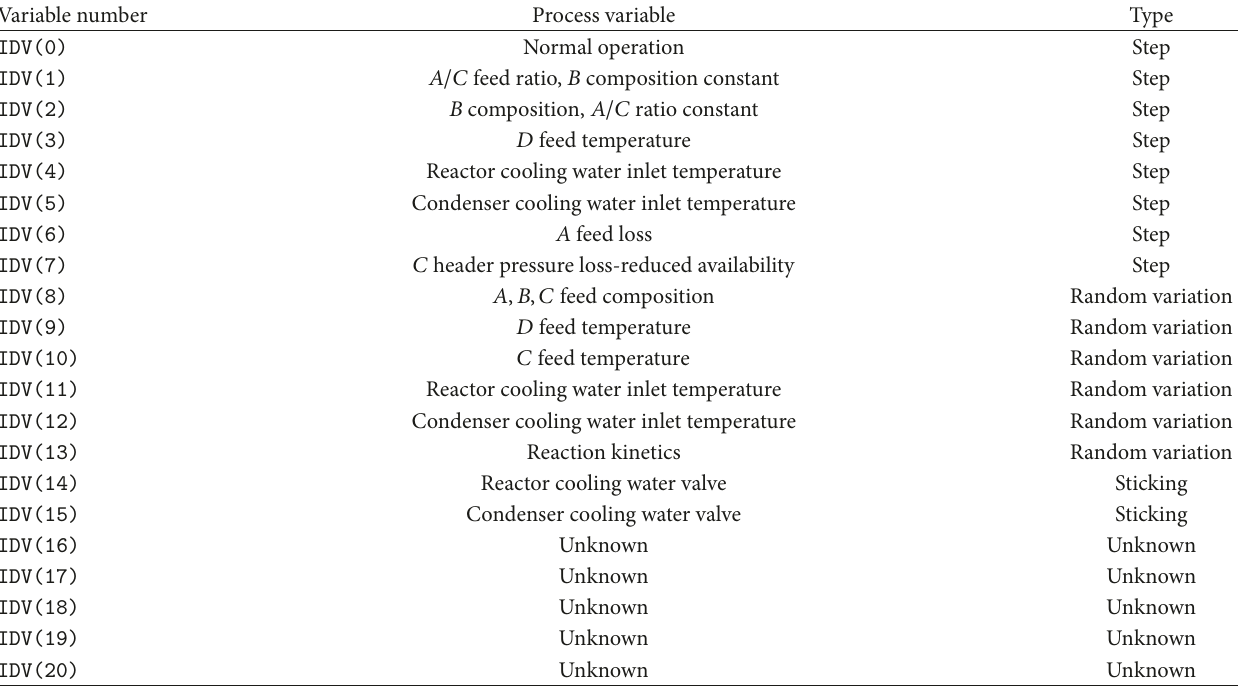
Table 3: Process faults.